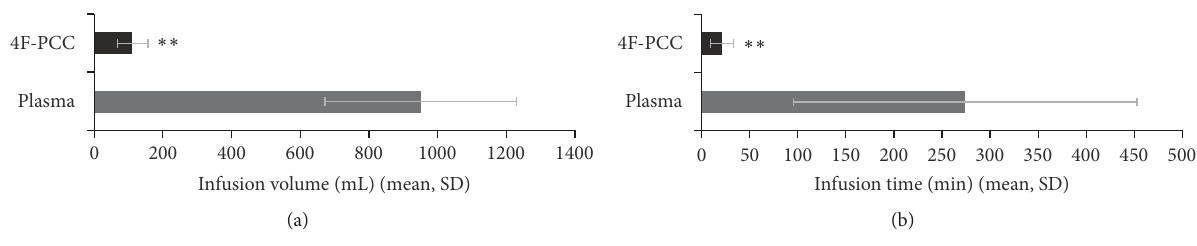
Figure 1: (a) Infusion volumes of study treatments. (b) Infusion times of study treatments. ∗∗ 𝑃 < 0.0001 compared with plasma. 4F-PCC, 4-factor prothrombin complex concentrate; min, minute; SD, standard deviation.